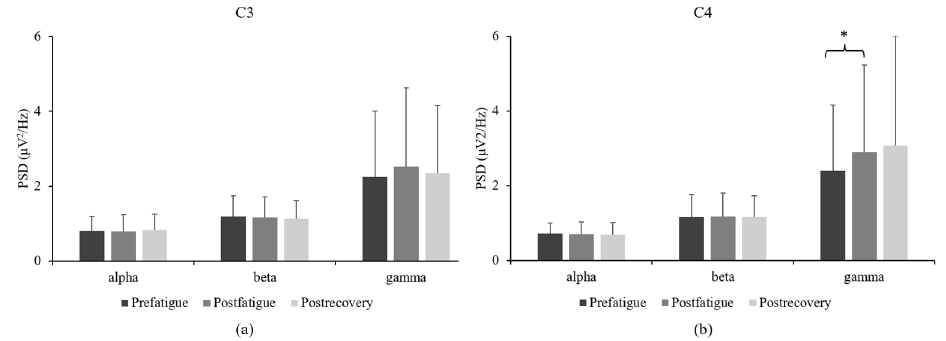
Figure 4. Comparison of ( a ) C3 power spectrum density and ( b ) C4 power spectrum density among the prefatigue, postfatigue, and postrecovery states. (* p < 0.05)